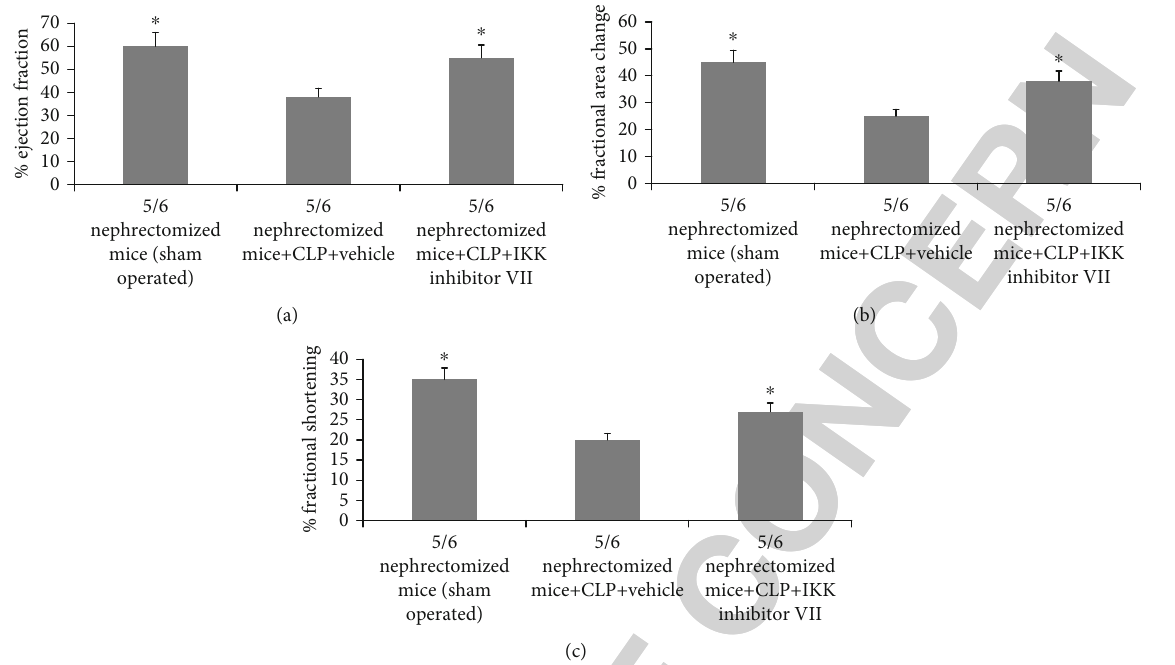
Figure 7: Blockade of IKK decreased the CLP-mediated cardiac dysfunction in animals subjected to 5/6 nephrectomy. 5/6 nephrectomized mice subjected to sham surgery or CLP. After 1 hour of CLP, the mice were exposed with either IKK inhibitor VII (1 mg/kg I.V.) or DMSO (2%) which was used as vehicle. The cardiac activity was evaluated after 24 hours. Data shows percentages of (a) EF, (b) FCA, and (c) FS. The groups studied were 5/6 nephrectomized mice and 5/6 nephrectomized sham mice; 5/6 nephrectomized, CLP, and vehicle treated, and 5/6 nephrectomized, CLP, and IKK inhibitor VII. All the results are presented as mean ± SEM . ∗ P < 0 : 05 compared to 5/6 nephrectomized mice, CLP, or vehicle-treated Table 3: E ff ect of IKK inhibitor VII on renal dysfunctioning and hepatic injury mediated by sepsis in 5/6 nephrectomized mice. 5/6 nephrectomized mice Parameter